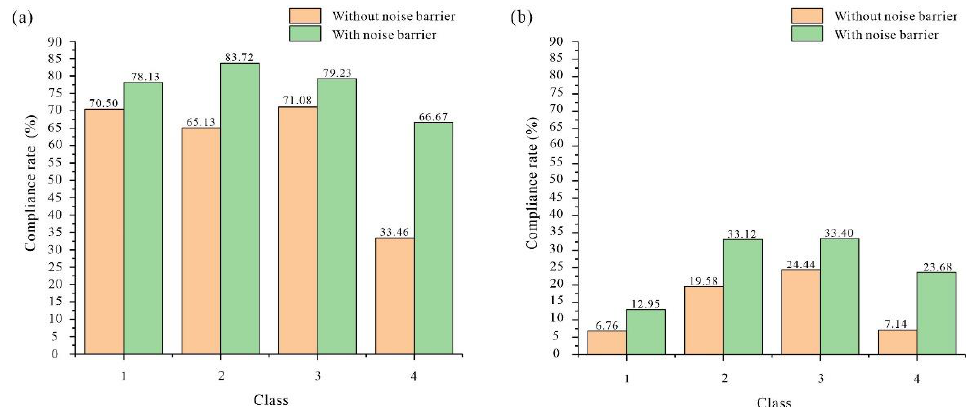
Figure 12. Comparison of the compliance rates of various acoustic environment functional areas between the cases with and without noise barriers. ( a ) Daytime; ( b ) nighttime.